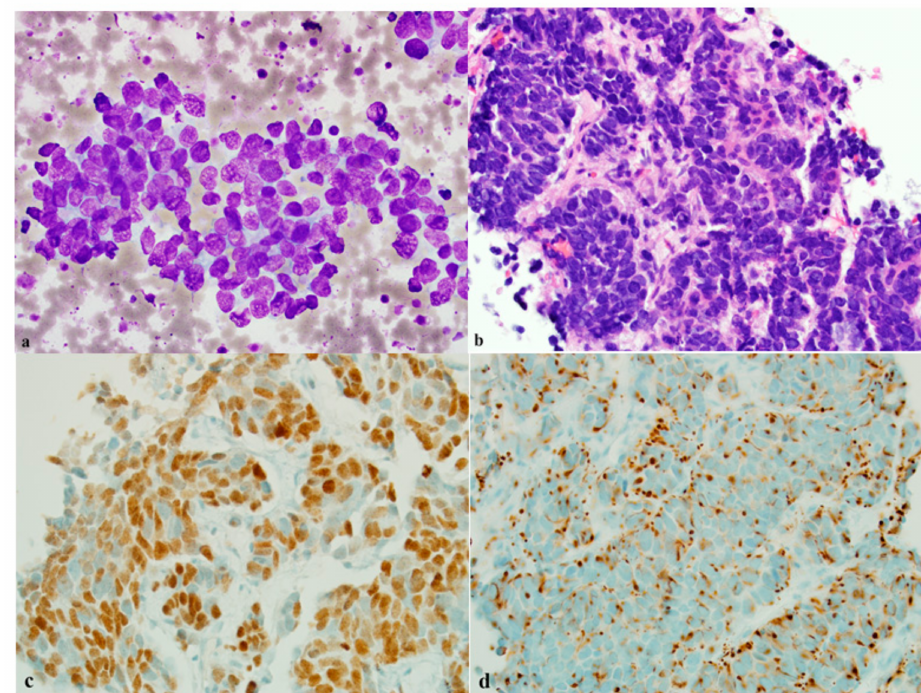
Figure 3. Merkel cell carcinoma. ( a ) Malignant cells are characterized by round to oval nuclei, high nuclear to cytoplasmic ratio, scant cytoplasm, and focal nuclear overlap on a smear ( × 400, Diff-Qiuk stain). ( b ) A small core biopsy shows nests of malignant cells ( × 200 H and E). ( c ) INSM1 stains nuclei of malignant cells strongly and diffusely on a core biopsy ( × 200, IHC). ( d ) CK20 is positive, perinuclear cytoplasmic staining on a core biopsy ( × 200,